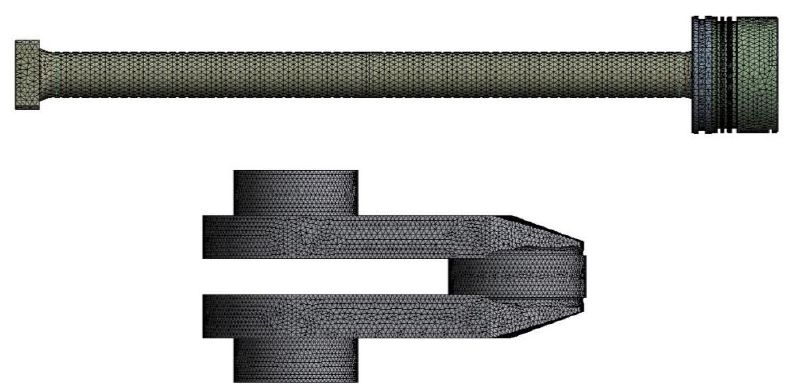
Figure 3. Meshing of connecting rod assembly.